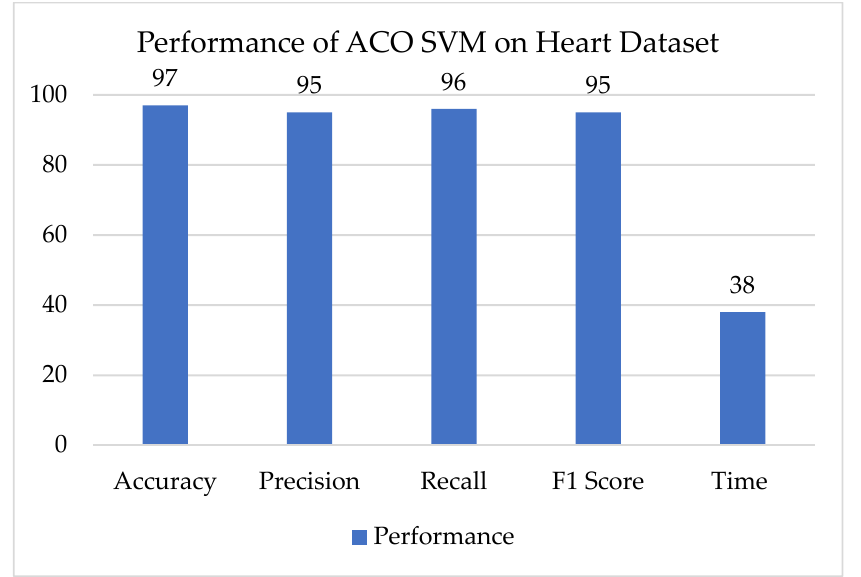
Figure 11. Performance of ACO ‐ SVM on Diabetes.